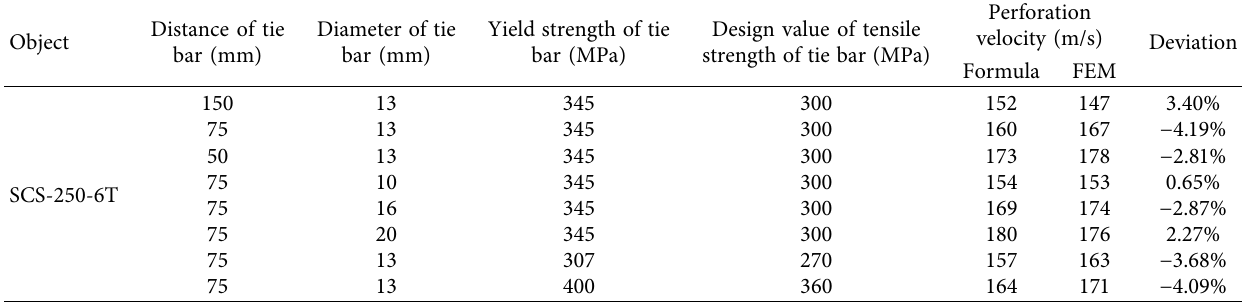
Table 8: Perforation velocity comparison of SCS-250-6T with different conditions of tie bar for flat projectile. Object